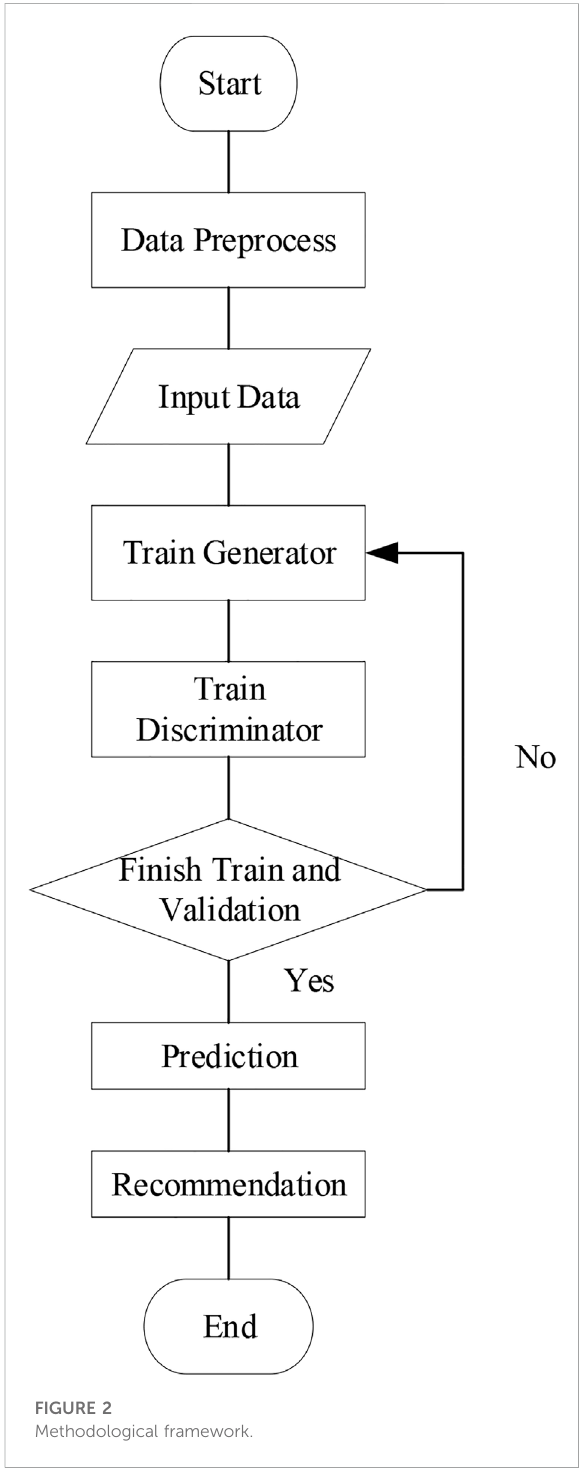
services, and x u,t + 1 represents the feature information of user u in the t+1st time series. G () is to train the generator function using the time series at time 0-t, which contains the weights for each hidden neuron.